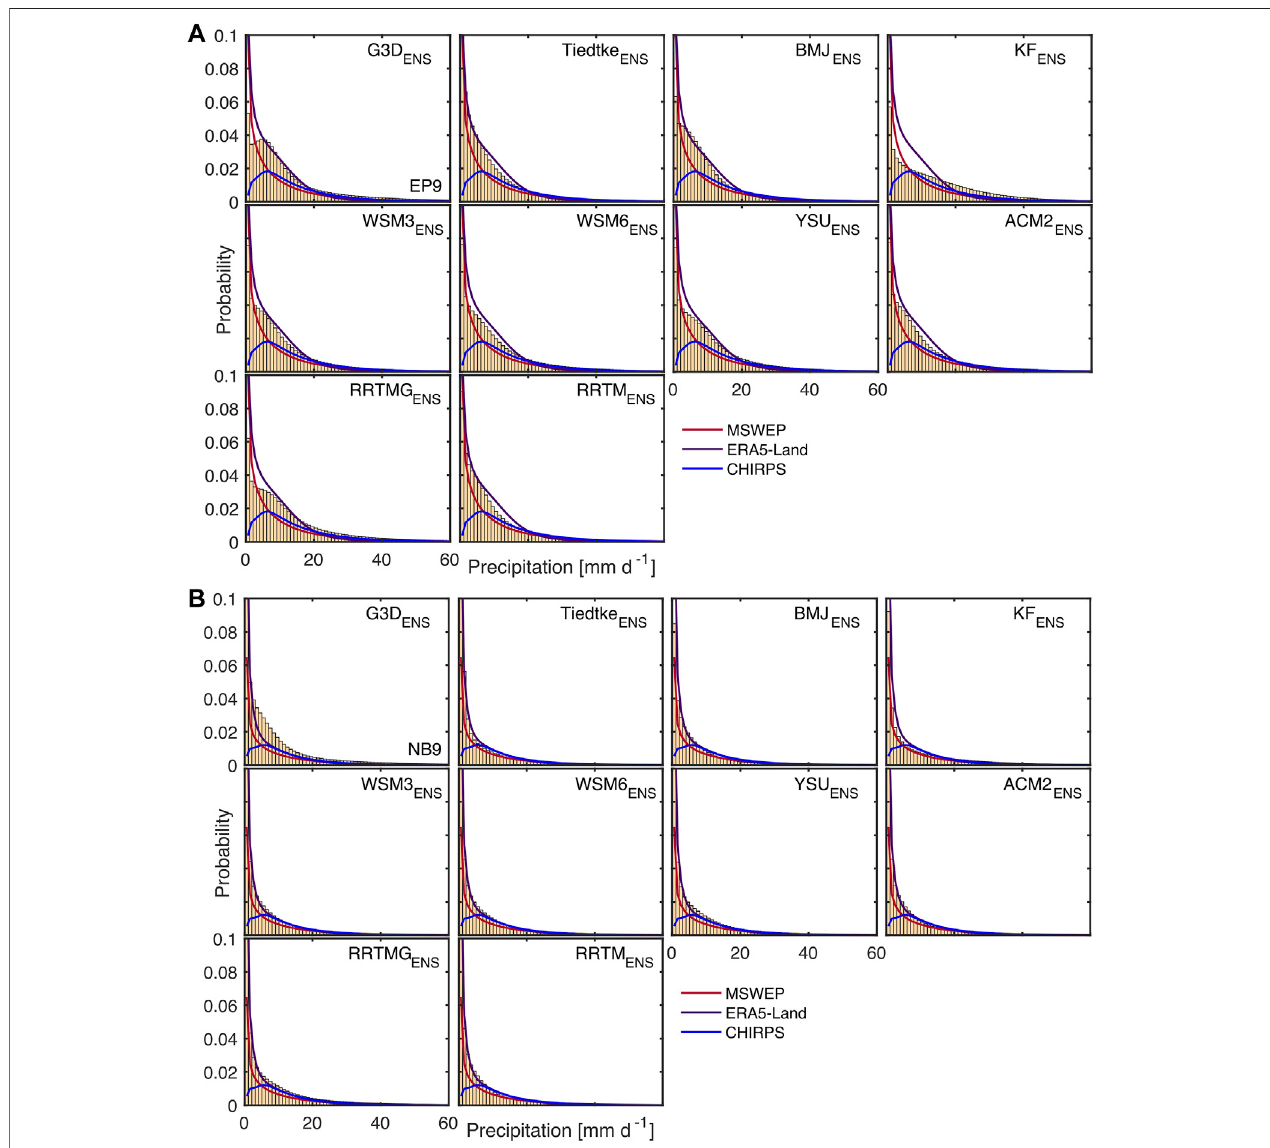
FIGURE 6 | Probability distribution of the parameterization sub-ensembles compared to CHIRPS, MSWEP and ERA5-Land for daily gridpoint-based precipitation of (A) EP9 and (B) NB9 from Jul 2006 till Jun 2008.